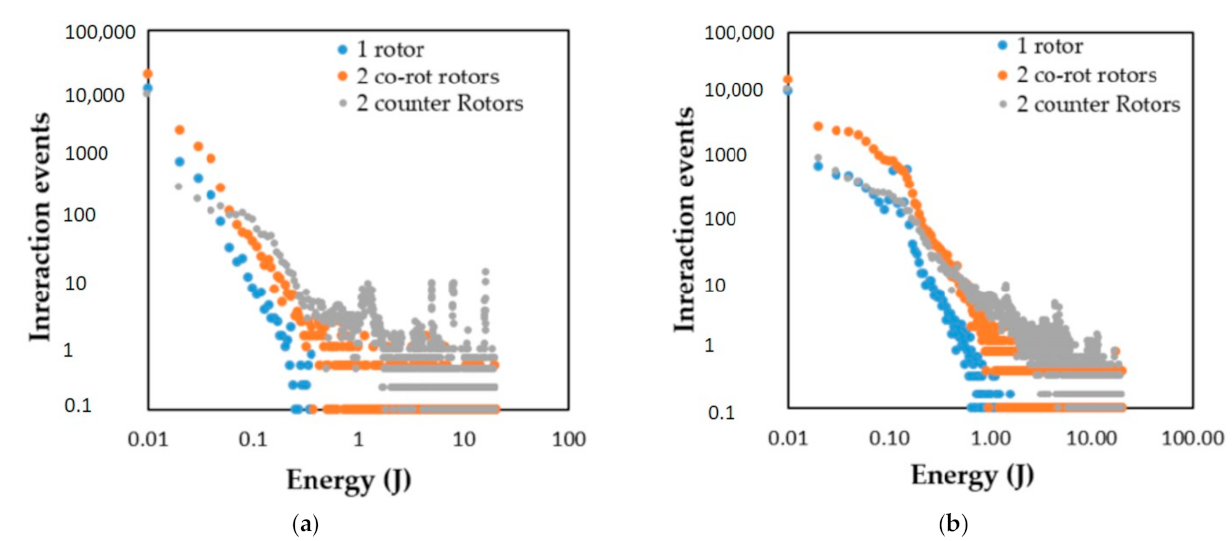
Figure 6. Comparison of the single rotor with double co-rotated and double counter-rotated rotors at ( a ) 1040 rpm and ( b ) 2080 rpm.